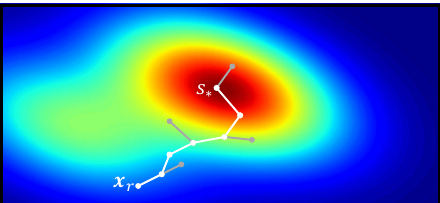
Figure 2. Search for highly informative stations. The color scale represents the informativeness, as measured by a predefined information metric, at a particular location. In particular, dark blue corresponds to low informativeness and red represents high informativeness. Algorithm 2 selects s the location with the highest informativeness among all x